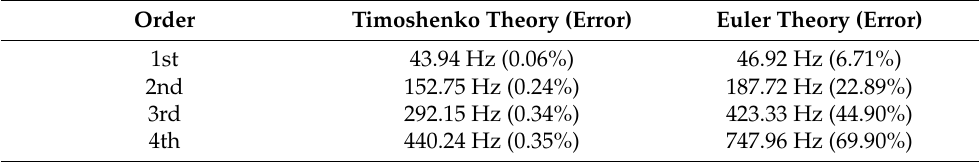
Table 1. Comparison of the first four modal frequencies between two beam theories.